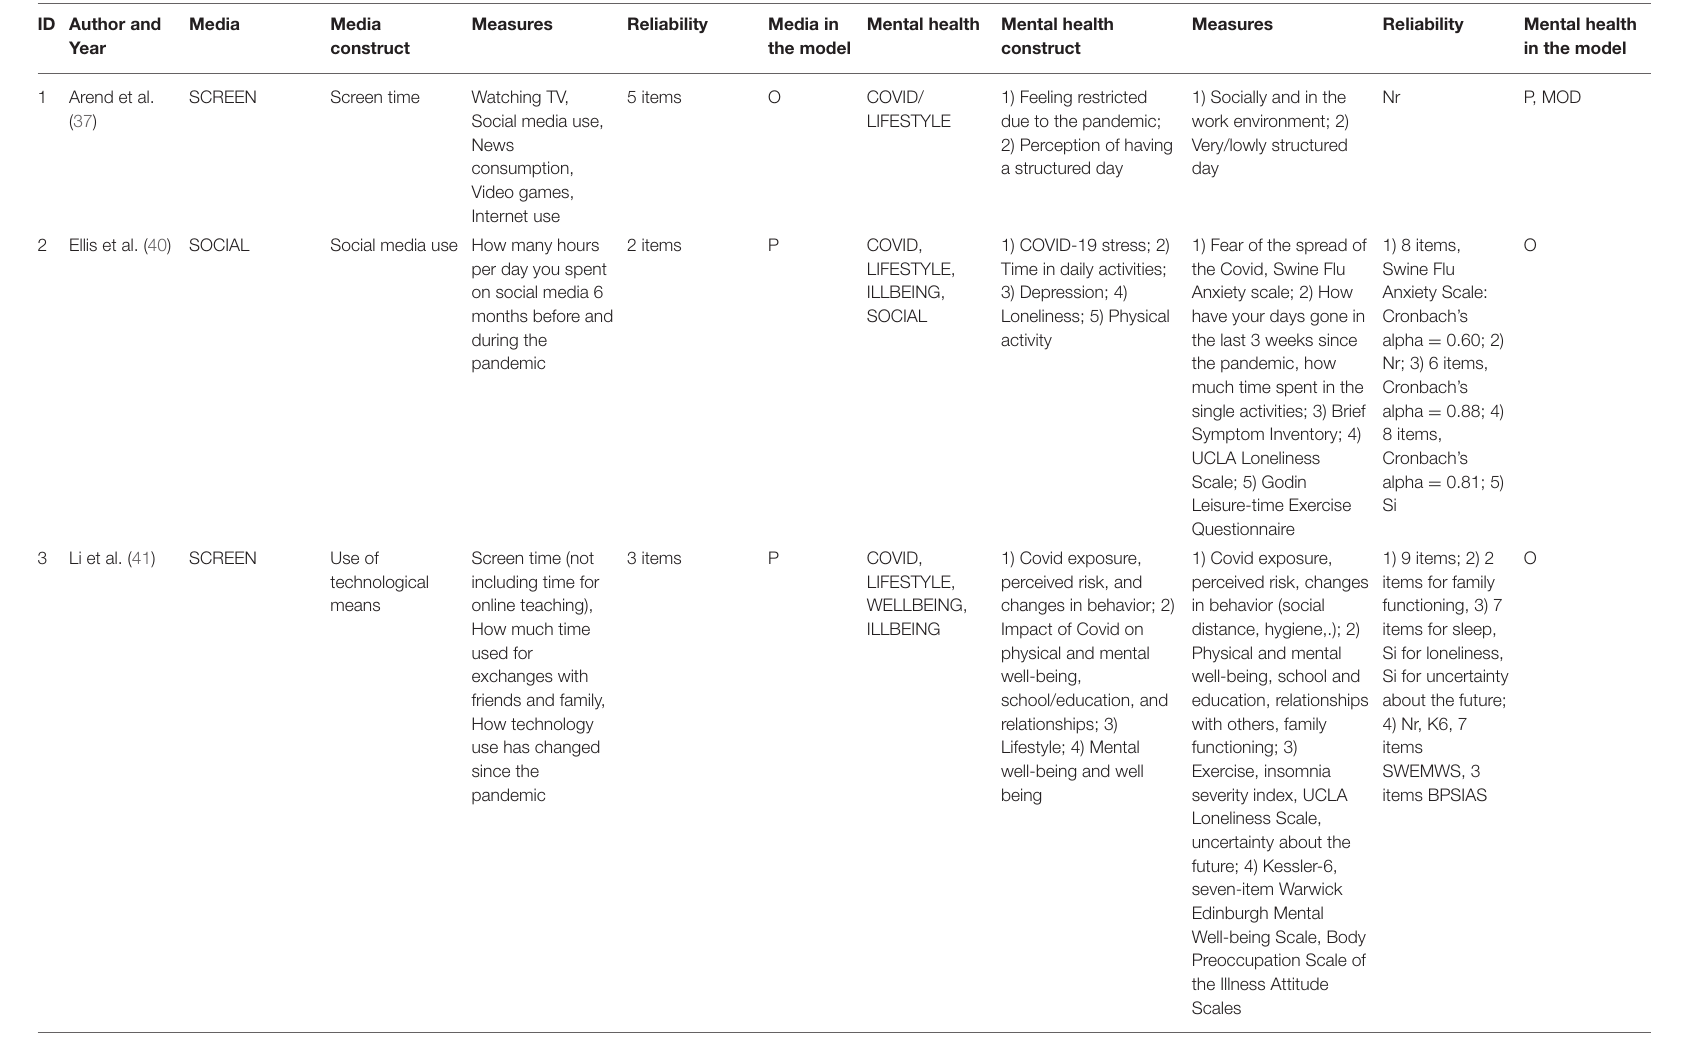
TABLE 5 | Digital media and well-being constructs